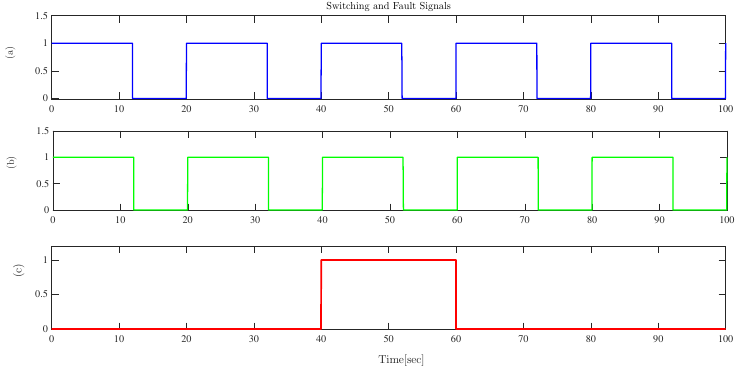
Figure 3. ( a ) Subsystem switching signal. ( b ) Observer switching signal. ( c ) Fault